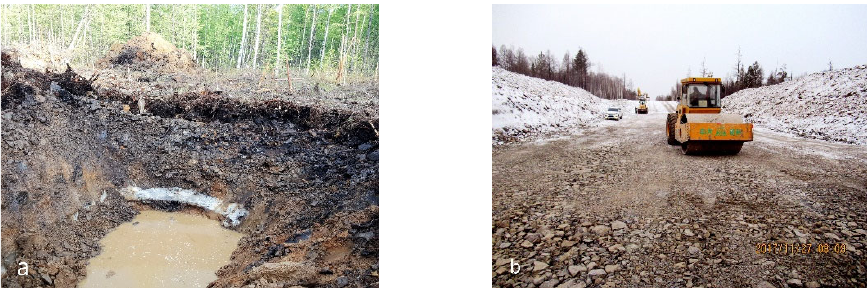
Figure 4. Site photos: ( a ) photo of surface soil layer and ( b ) compaction photo of the block–stone layer.